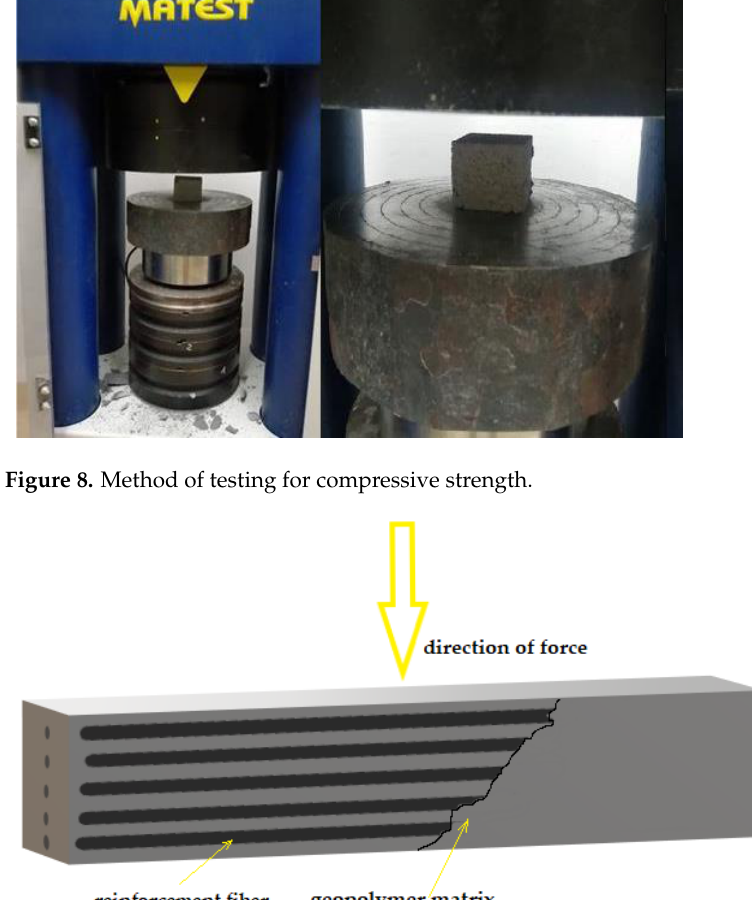
Figure 9. Way of applying a force to a sample reinforced with long fibers.